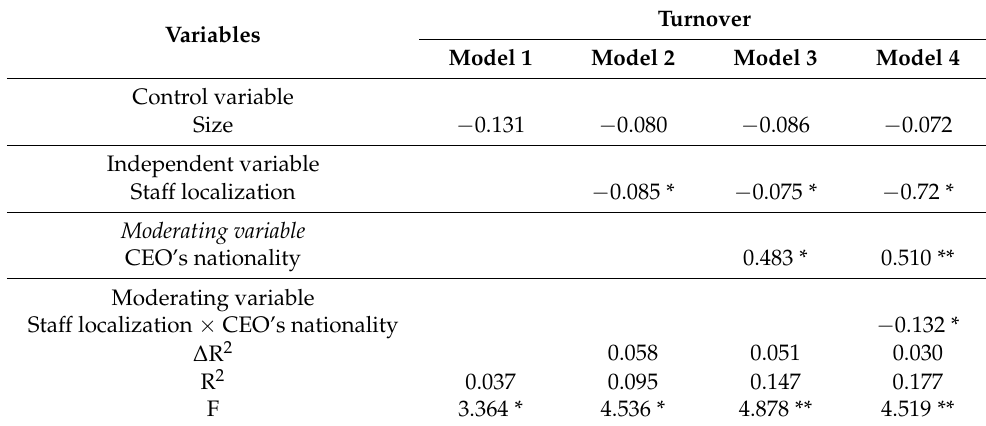
Table 3. Results of hierarchical linear